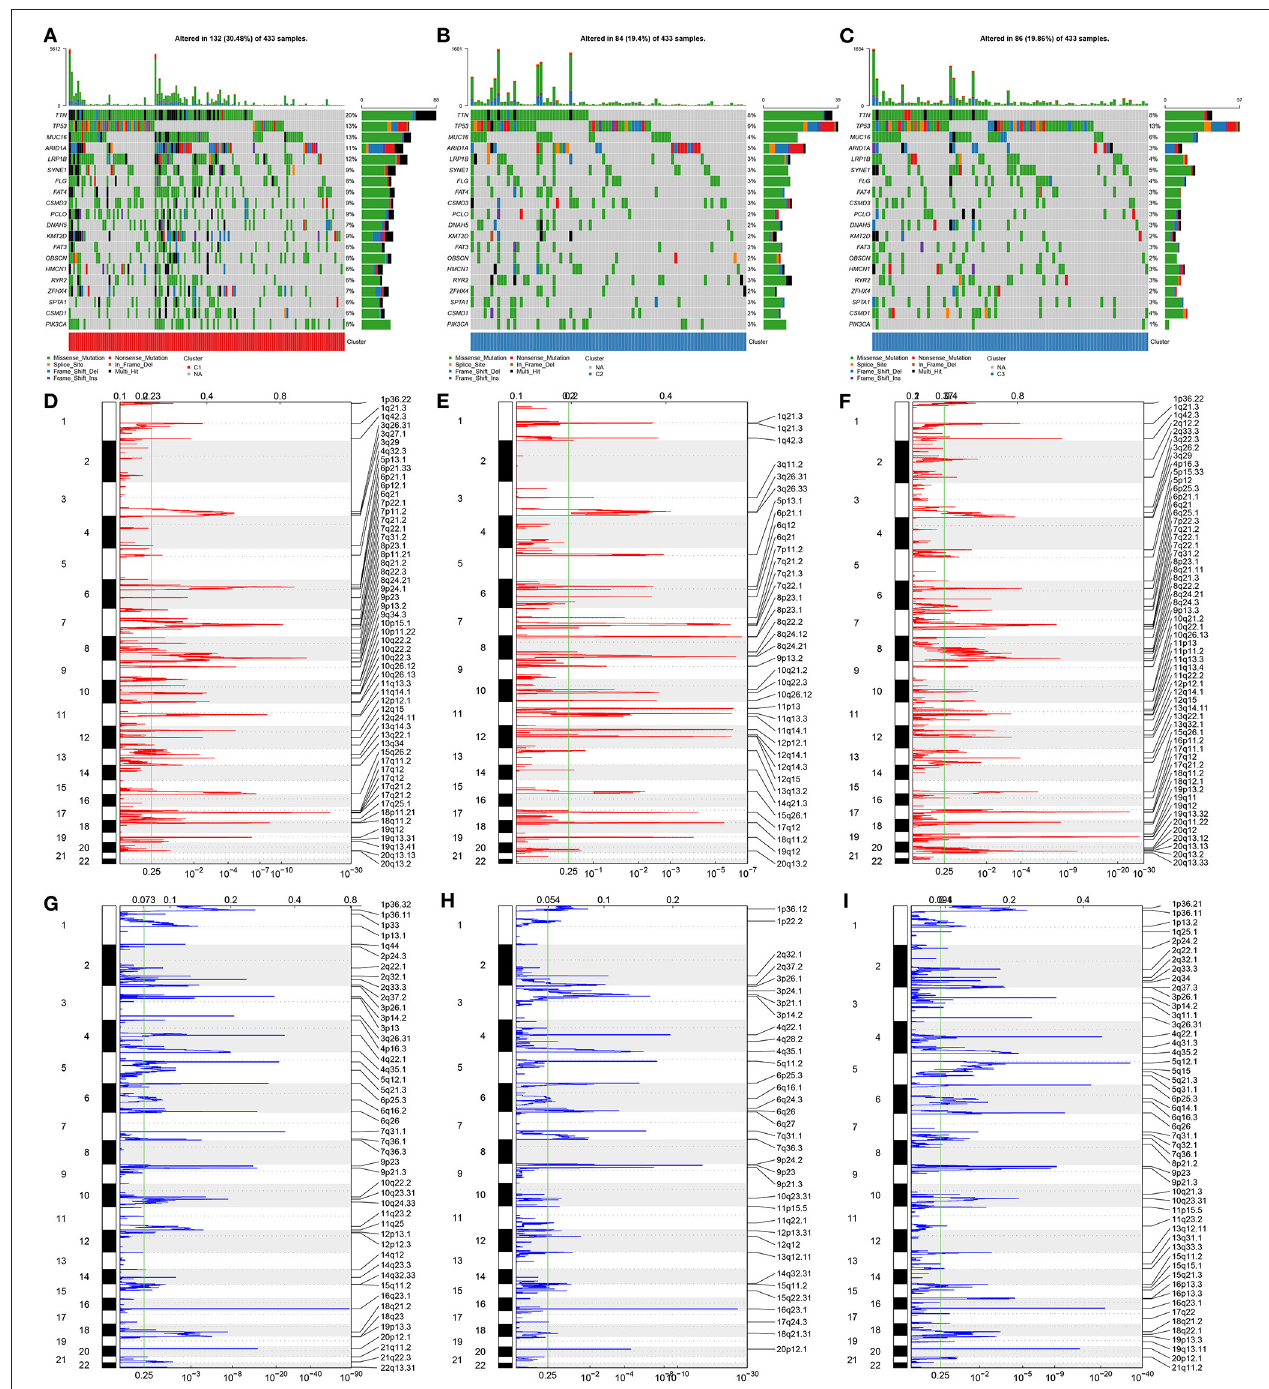
FIGURE 2 | Aging-relevant molecular phenotypes with diverse cancer mutational genomes. (A–C) Oncoprint of somatic mutation status across patients with gastric cancer in aging-related molecular phenotypes (A) C1, (B) C2, and (C) C3. Individual patients were represented in each column. The right bar plots showed the mutation frequencies of the first 20 mutated genes in each molecular phenotype. (D–F) The amplifications of genes were separately shown in molecular phenotypes (D) C1, (E) C2, and (F) C3. The false-discovery rate ( q value) and scores for amplifications were plotted against genomic locations. (G–I) The deletions of genes were separately shown in molecular phenotypes (G) C1, (H) C2, and (I) C3. The q -value and scores for deletions were depicted against genomic locations. Dotted lines indicated the centromeres. The green line represented 0.25 of q -value cutoff value that determined significance.